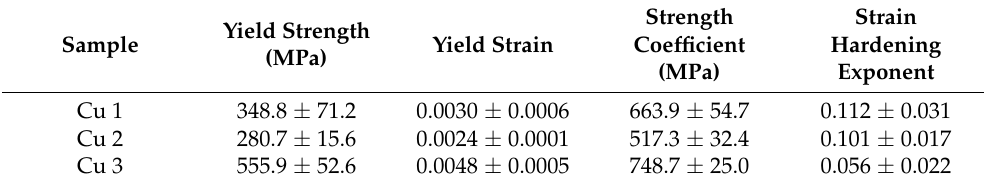
Table 6. Flat-punch indentation yield strength, yield strain, strength coefficient, and strain hardening exponent for Cu